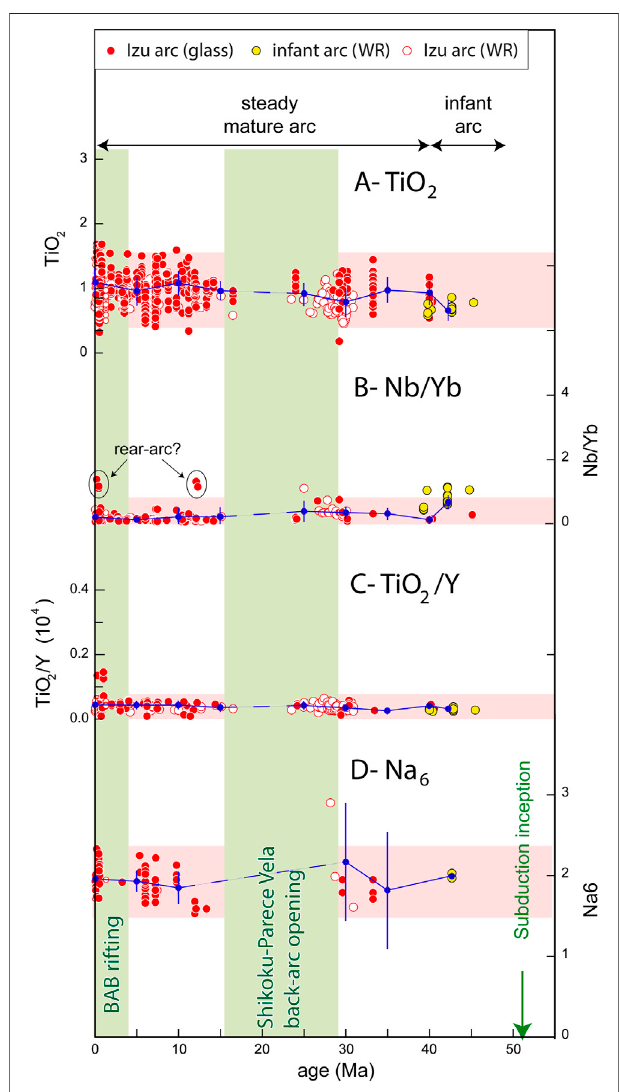
FIGURE 7 | Temporal evolution of the degree of mantle melting and mantle depletion. (A) TiO 2 (wt%), (B) Nb/Yb, (C) TiO 2 /Y, (D) Na 6 (wt%) diagrams used to examine the compositional evolution of the mantle source (Nb/YbandTiO 2 /Y)andextentofmelting(TiO 2 andNa 6 )overtime.Some of the outliers may belong to the rear-arc, as suggested in Figure 6 . The blue line represents an averaged composition of the proxies with 1 σ error